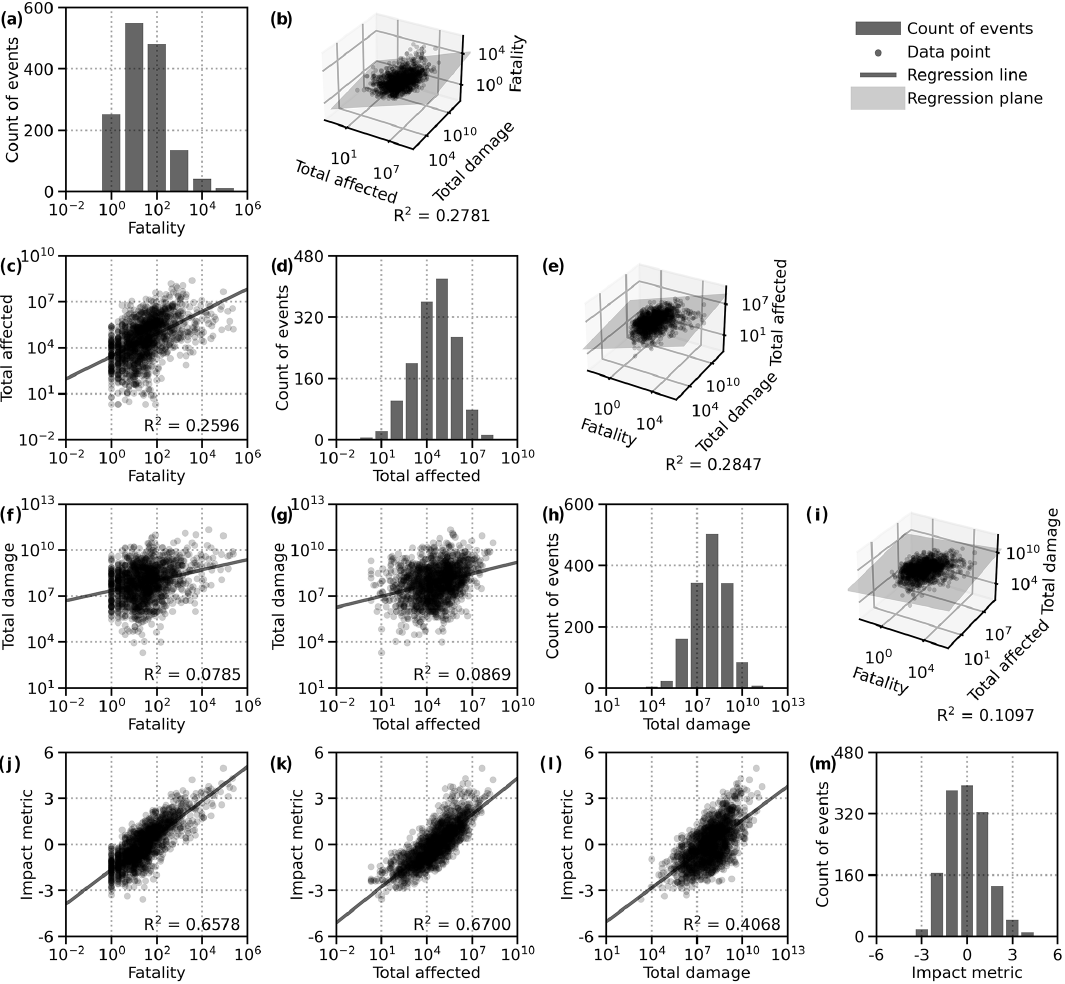
Figure 2. Impact variables and impact metric. (a) Histogram of impact variable fatality. (b) Fatality regressed on total affected population and total damage in 2019 USD with a multiple linear regression. (c) Total affected population regressed on fatality with a simple linear regression. (d) Histogram of impact variable total affected population. (e) Total affected population regressed on fatality and total damage in 2019 USD with a multiple linear regression. (f) Total damage in 2019 USD regressed on fatality with a simple linear regression. (g) Total damage in 2019 USD regressed on total affected population with a simple linear regression. (h) Histogram of impact variable total damage in 2019 USD. (i) Total damage in 2019 USD regressed on fatality and total affected population with a multiple linear regression. (j) Impact metric regressed on fatality with a simple linear regression. (k) Impact metric regressed on total affected population with a simple linear regression. (l) Impact metric regressed on total damage in 2019 USD with a simple linear regression. (m) Histogram of impact